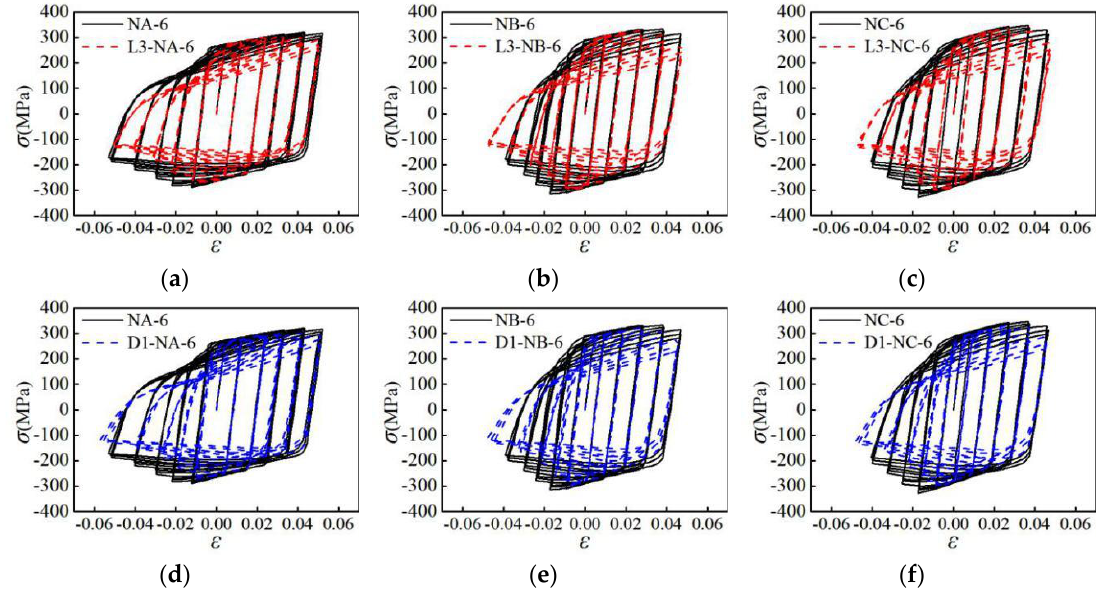
Figure 15. Influence of specimen size on hysteresis curves: ( a ) group A of specimens with different parallel section length; ( b ) group B of specimens with different parallel section length; ( c ) group C of specimens with different parallel section length; ( d ) group A of specimens with different parallel section diameter; ( e ) group A of specimens with different parallel section diameter; ( f ) group A of specimens with different parallel section diameter.